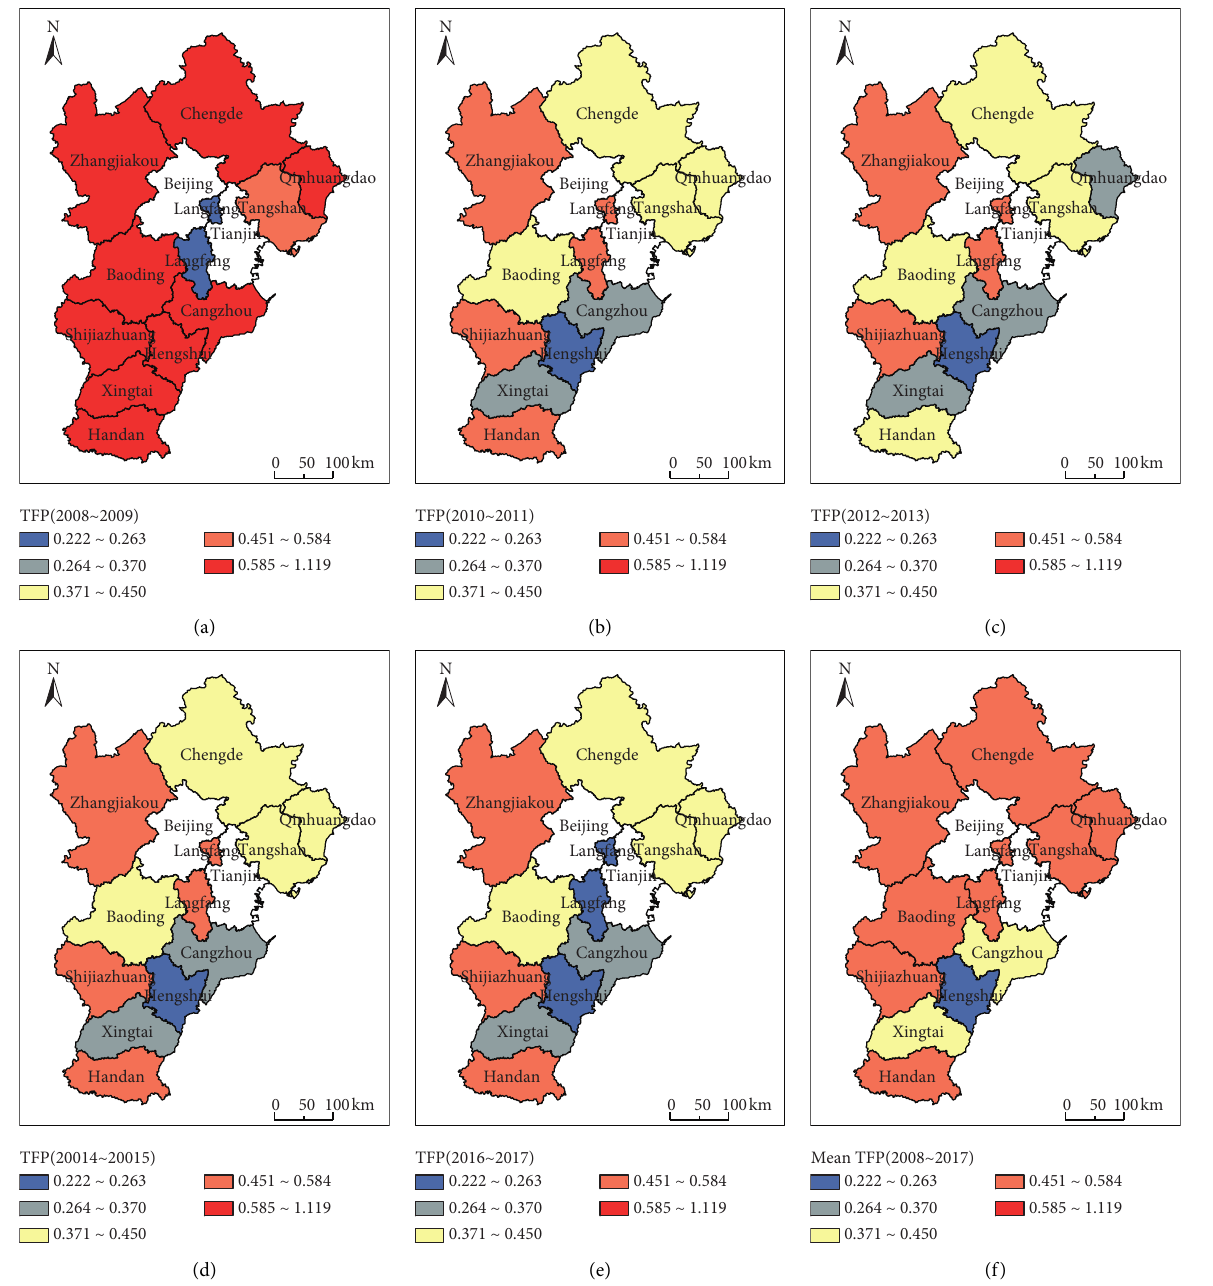
Figure 2: TFP of service industries of Hebei Province, China (2008 ∼ 2009, 2010 ∼ 2011, 2012 ∼ 2013, 2014 ∼ 2015, 2016 ∼ 2017, and